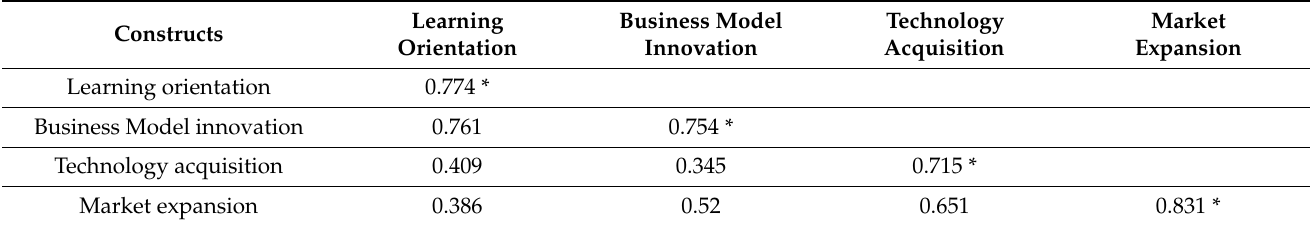
Table 4. Results of discriminant